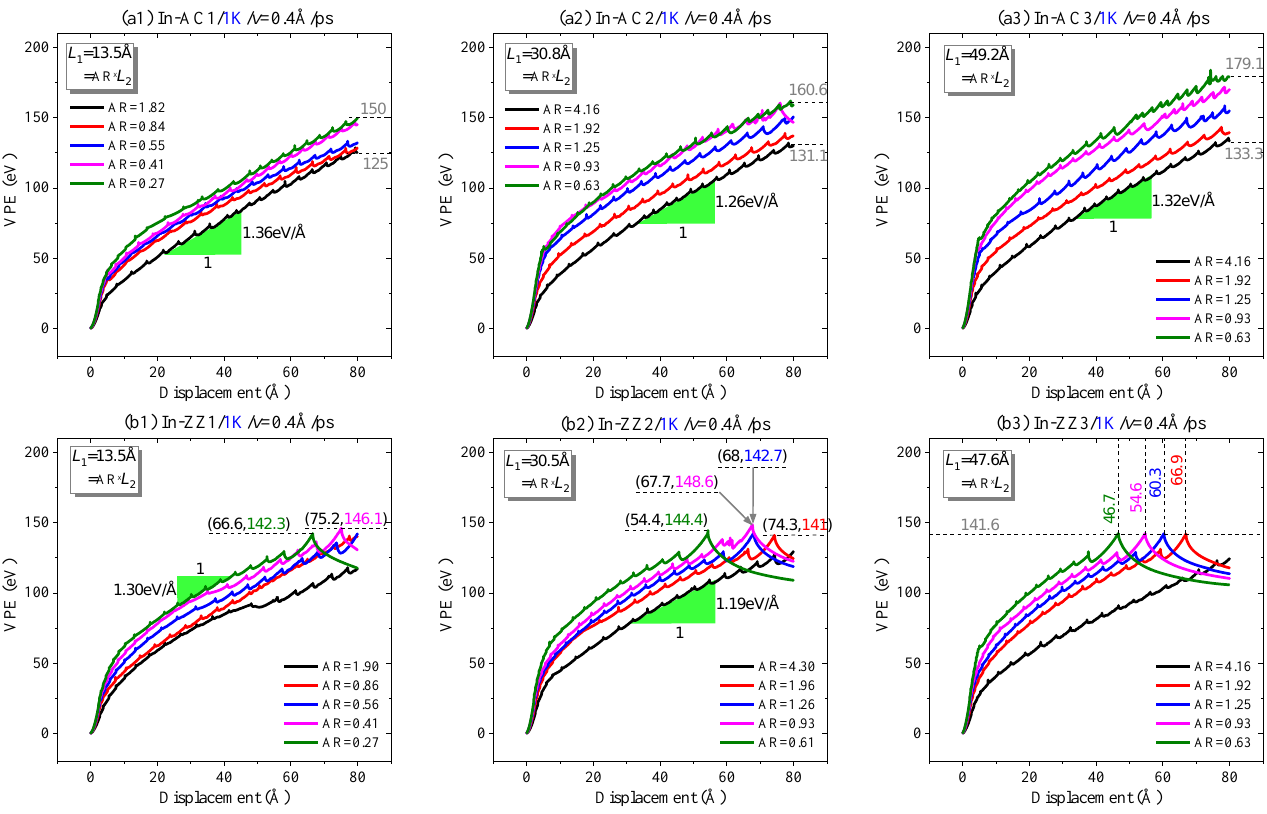
Figure 4. Curves of VPE vs. the in-plane tearing displacement of graphene ribbons with v = 0.4 Å/ps and different aspect ratios at 1 K: ( a1 – a3 ) an armchair crack in the sheet, ( b1 – b3 ) a zigzag crack in the sheet.